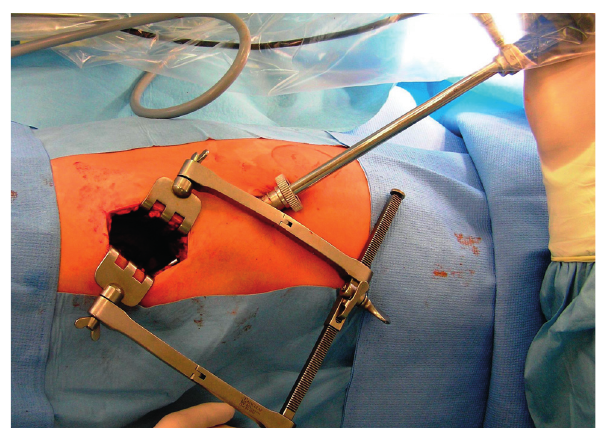
Fig. 2. OP view retractor is placed and port for endoscope is located cranially.